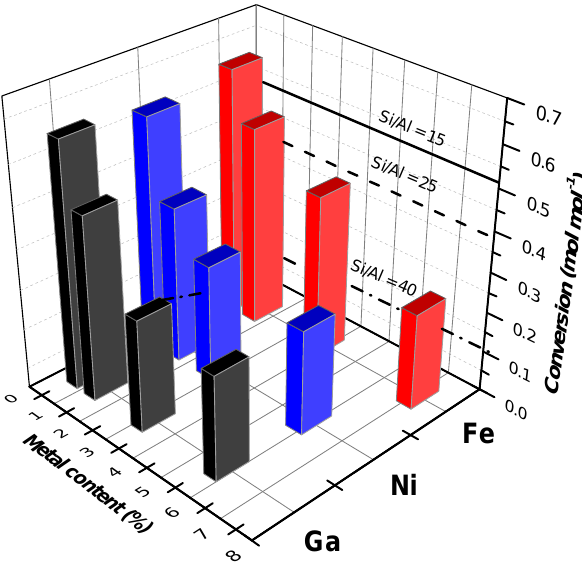
Figure 6. Catalyst screening on the HTK-S of different ZSM-5 catalysts including Fe, Ni and Ga modified ZSM-5 with different metal content (indicated as bars) and unmodified H-ZSM-5 with different Si/Al (indicated as lines in x – z plane: full: Si/Al = 15; dashed: Si/Al = 25 and dot dash: Si/Al = 40) and its effect on the conversion( T = 623 K; p EtOH = 10 kPa, W/F° EtOH = 17 kg·s·mol − 1 , t react = 2 h).